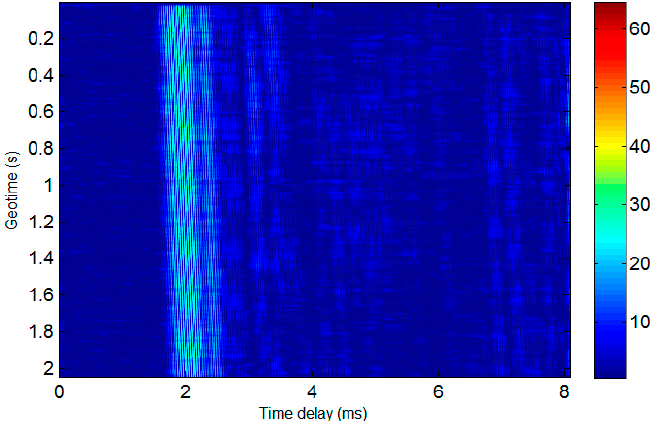
Figure 8. Response of the experimental channel for the first trial.